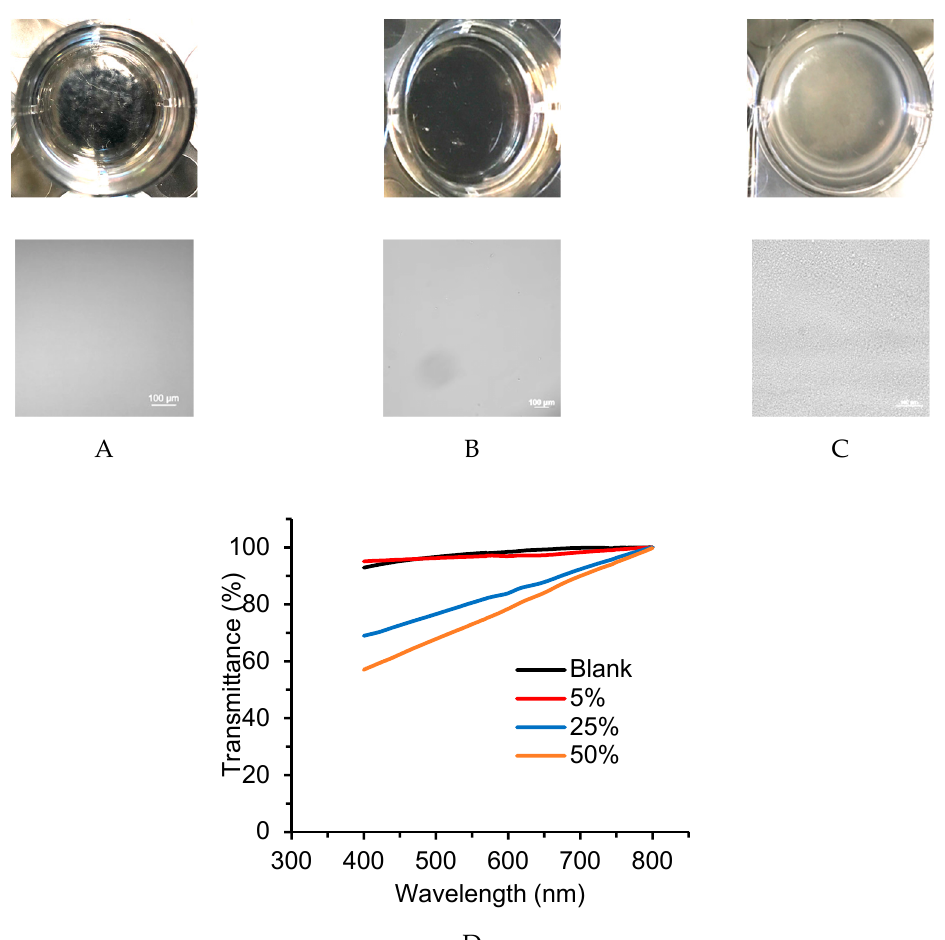
Figure 6. Optical pictures of samples containing 50 wt% different oils in cured silicone gels (Top optical image, bottom microscope image X10) ( A ) linear polydimethylsiloxane MW 28,000 g mol − 1 , ( B ) 4 arm linear 16 , ( C ) 4 arm T(TM 2 ) 13 . ( D ) Transmittance at various wavelengths of different concentrations of 13 the uncured silicone pre-elastomer.